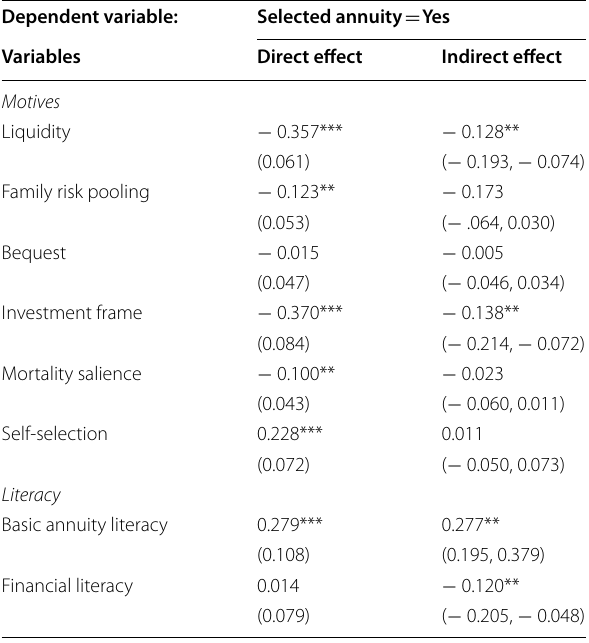
This table presents the log-odds direct and indirect effects of the motive and literacy variables. The mediator is taken as annuity antipathy (dislike of annuities). The dependent variable is whether the individual selected the annuity in the hypothetical scenario question. Robust standard errors and 95% CI in parentheses for direct and indirect effects. Effects are expressed in log- odds. *** p < 0.01, ** p < 0.05, * p <